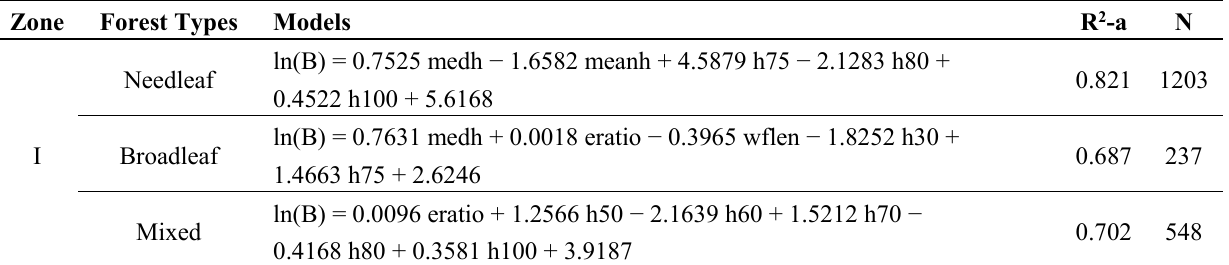
Figure 4. Comparison of biomass estimated from models using GLAS footprints on all slopes (purple crosses in model III), slopes <20° (brown squares in model I), and slopes ≥ 20° (green triangles in model II) with field survey biomass (blue diamonds) in forest zones II ( a ), III ( b ), IV ( c ), and VII ( d ). Models I and II were trained by GLAS waveform data on slopes <20° and ≥ 20°, respectively. Models III were developed from GLAS waveform data on all slopes. Table 5. Optimized models of AGB estimated from GLAS waveform data. R 2 were the Goodness of Fit for different forest types in the six forest zones. I is cold temperate zone, II is temperate zone, III is warm temperate zone, IV is subtropical zone, V is tropical zone and VII is Qinghai-Xizang plateau alpine zone . (B = biomass, N = number of GLAS footprints sampled by forest plots used in each